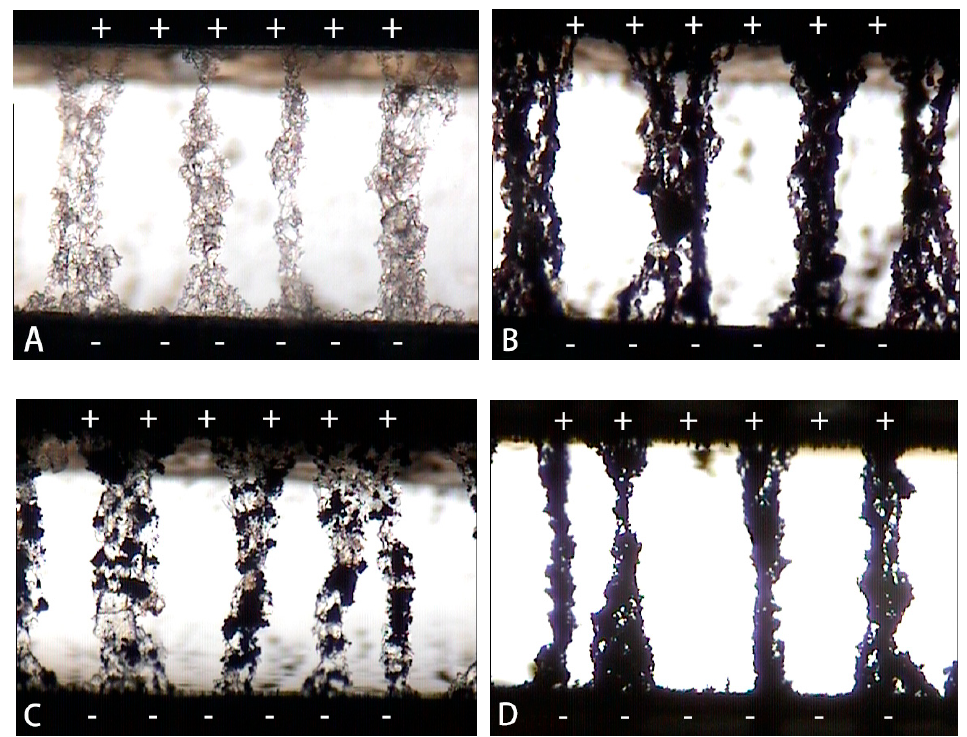
Figure 7. Optical microscopy image of the suspensions under electric fields: ( A ) P[VBTMA][PF 6 ]; ( B ) P[VBTMA][PF 6 ]-c-PANI (40 wt %); ( C ) P[VBTMA][PF 6 ]/PANI (40 wt %) mixture; ( D ) PANI.